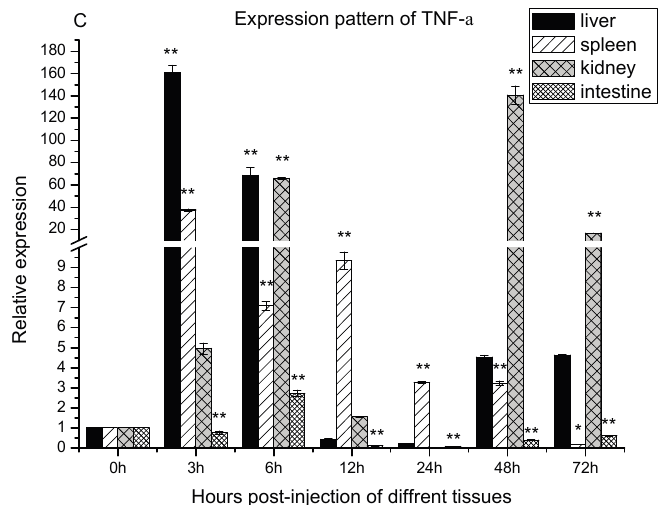
Figure 4. The expression of MR, interleukin-1 β (IL-1 β ) and TNF- α after Aeromonas sobria infection. Expression patterns of MR ( A ); IL-1 β ( B ) and TNF- α ( C ) were determined in liver, spleen, kidney and intestine by qRT-PCR. The samples were analyzed at 0, 3, 6, 12, 24, 48 and 72 h post-injection. Expression of β -actin was used as internal control for qRT-PCR. Each experiment was performed in triplicate. Data were shown as mean ± SE ( n = 3). The asterisk indicated a statistically significant difference ( ** p < 0.01, * p < 0.05) compared with 0 h (set as